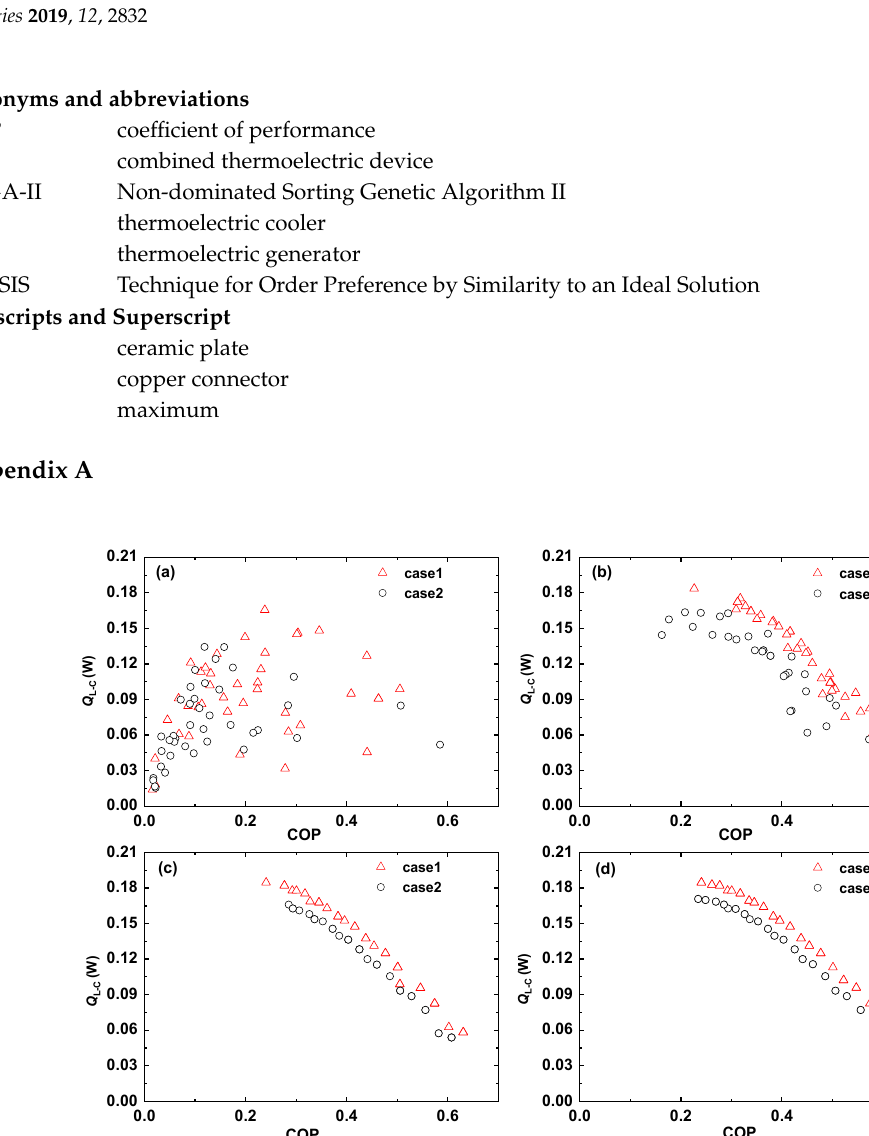
Table A1. The value of search variables and performance metrics for the improved CTE